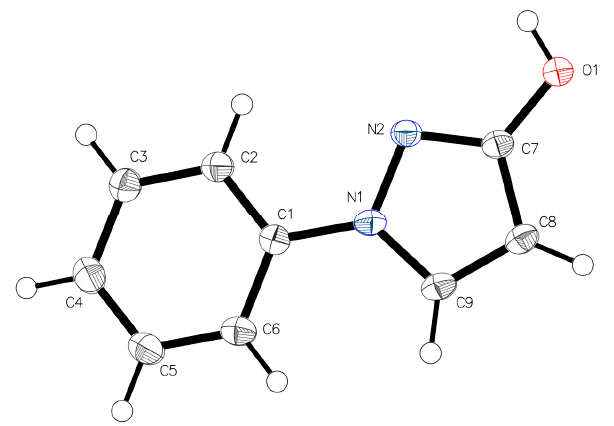
Table 1. Experimental parameter and CCDC-Code.